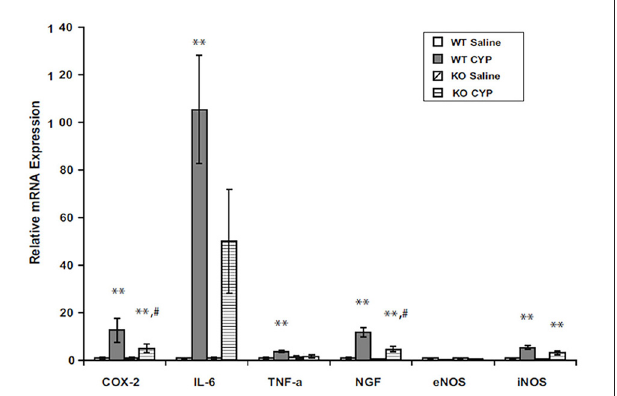
FIGURE 3 | Bladder content of mRNA for inflammatory mediators in male WT and FAAH KO mice treated with saline (controls) or CYP (150 mg/kg) given intraperitoneally 3 h prior to sacrifice. Total bladder RNA was extracted, RT-PCR was performed, and results were normalized to signal for L19, a ribosomal protein. ∗∗ p < 0.05 CYP vs. saline for each genotype; # p < 0.05 CYP treated KO vs. CYP treated WT; n = 6–8 for each genotype and treatment. Reprinted by permission from the publisher of Journal of Molecular Neuroscience, Nature/Springer/Palgrave; (Wang et al.,